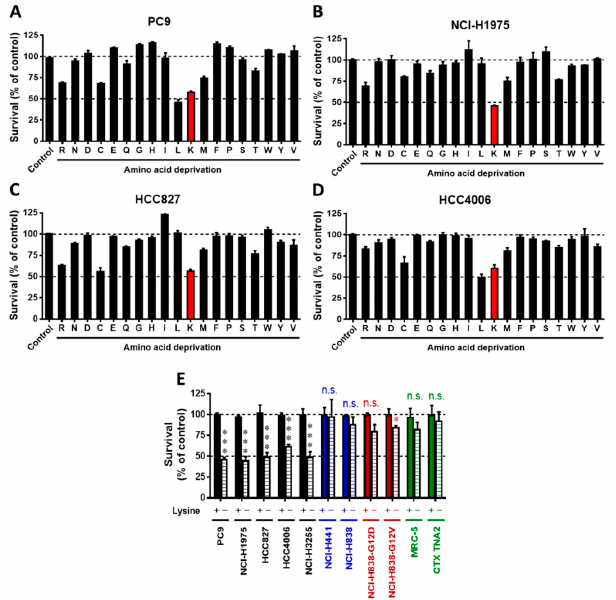
Figure 1. The epidermal growth factor receptor ( EGFR )-mutant non-small cell lung cancer (NSCLC) cells were consistently sensitive to lysine deprivation. EGFR- mutant NSCLC cells (( A ): PC9, ( B ): NCI- H1975, ( C ): HCC827, and ( D ): HCC4006) were deprived of each amino acid for 48 h, and their survival was analyzed using an SRB assay. ( E ) The response to lysine deprivation in EGFR -mutant NSCLC cells (black bar: PC9, NCI-H1975, HCC827, HCC4006, and NCI-H3255), EGFR wild-type NSCLC cells (blue bar: NCI-H441 and NCI-H838; dark red bar: KRAS -G12D and KRAS -G12V isogenic cells), and normal cells (green bar: normal human lung MRC-5 fibroblasts and normal rat astrocytes, CTX TNA2). The SRB analysis results shown are representative of three independent experiments. The data are presented as the mean ± SD. (***, p < 0.001; *, p < 0.05 compared with the control); n.s., non-significant; SRB, sulforhodamine B. The concentration of each amino acid used is described in Table A1 in Appendix